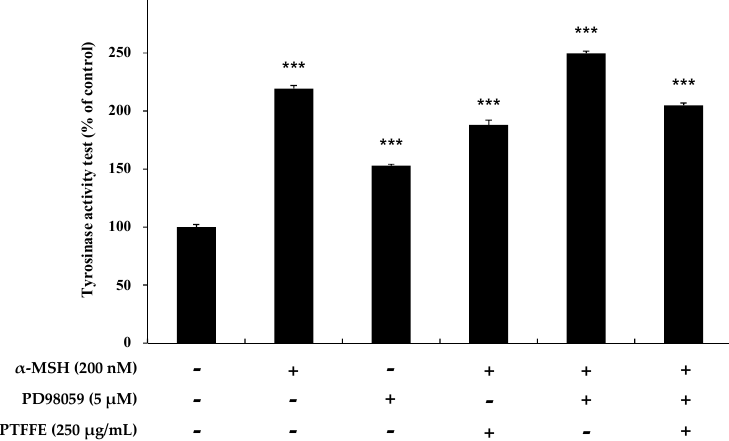
Figure 8. Effects of the ERK inhibitor PD98059 on tyrosinase activity in B16F10 cells. Cells were treated with α-MSH (200 nM) or PD98059 (5 μM) alone or in combination and with or without PTFFE at the single concentration of 250 μg/mL. Data are expressed as percentages of the untreated cells. The data are presented as the mean ± SD of at least three independent experiments. *** p < 0.001.